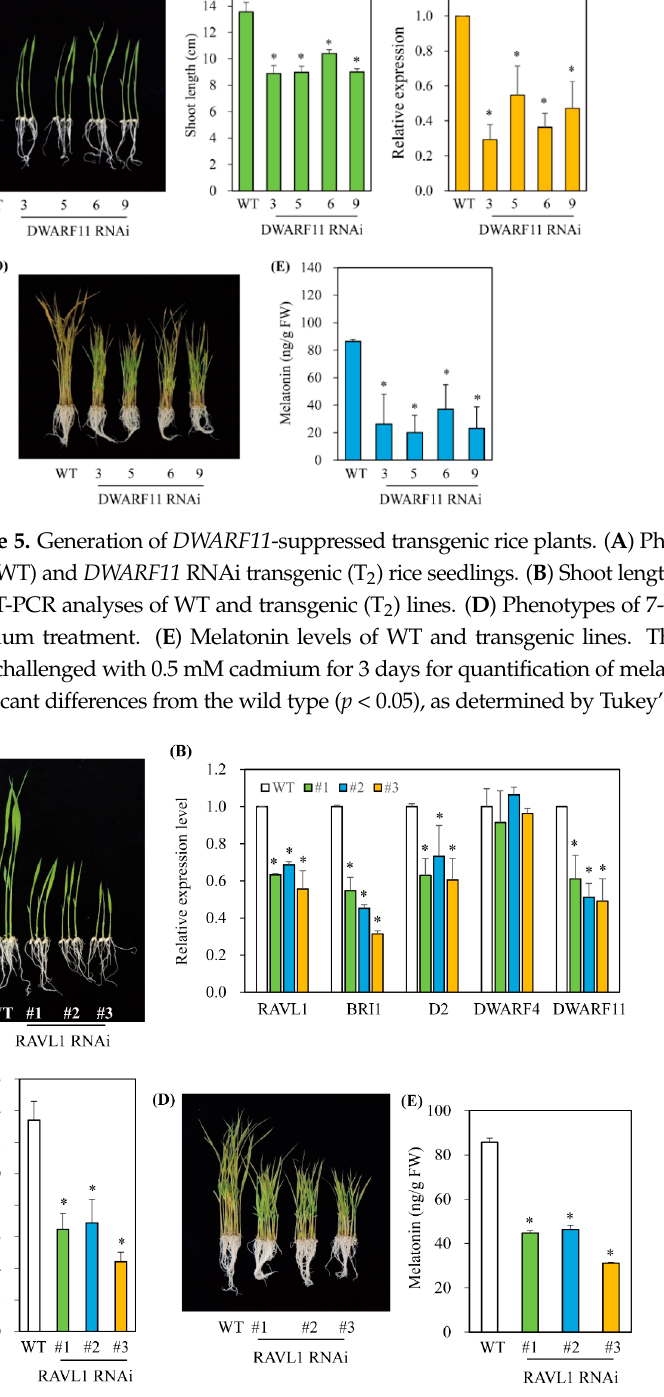
Figure 6. Generation of RAVL1 -suppressed transgenic rice plants. ( A ) Phenotypes of 7-day-old wild-type (WT) and RAVL1 RNAi transgenic (T 2 ) rice seedlings. ( B ) Shoot length measurement. ( C ) qRT-PCR analyses of WT and transgenic (T 2 ) lines. ( D ) Phenotypes of 7-day-old rice seedling after cadmium treatment. ( E ) Melatonin levels of WT and transgenic lines. The 7-day-old rice seedlings were challenged with 0.5 mM cadmium for 3 days for quantification of melatonin. Asterisks (*) indicate significant differences from the wild type ( p < 0.05) as determined by Tukey’s HSD post hoc tests. GenBank accession numbers are Os04g0581400 ( RAVL1 ), AK101085 ( BRI1 ), XP_015755947 ( D2 ), AK106528 ( DWARF11 ), AB206579 ( DWARF4 ), and Os03g13170 ( UBQ5 ).